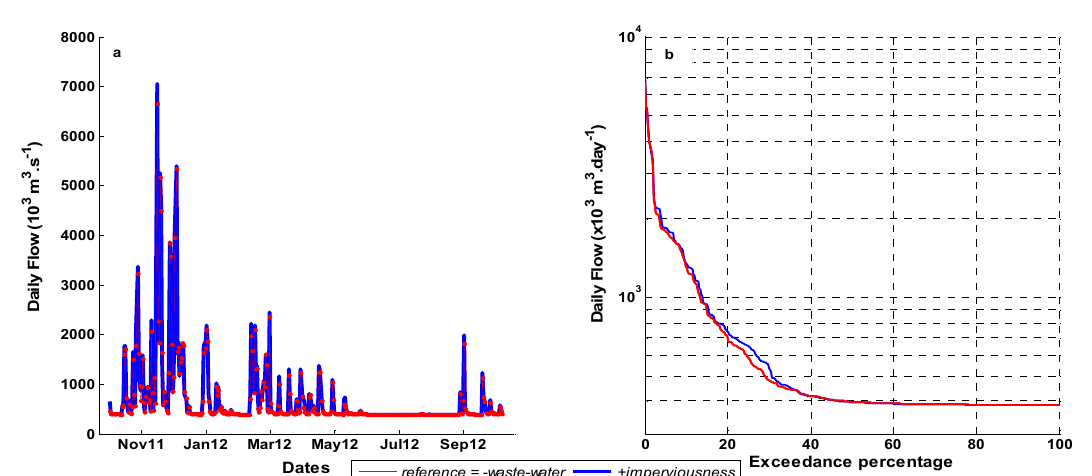
Figure 6. ( a ) Hydrogram for scenarios reference and -waster_water (red line), +imperviousness (blue line). ( b ) Daily flow duration curves for scenarios reference and -waster_water (red continuous line) +imperviousness (blue continuous line). In ( b ) the scale of the vertical axis is logarithmic and the plateau at high exceedance percentage corresponds to dry weather periods.